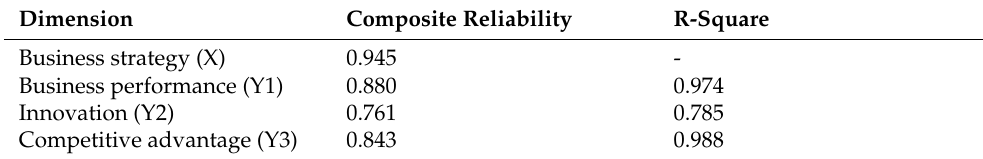
Table 4. Composite reliability calculation results.